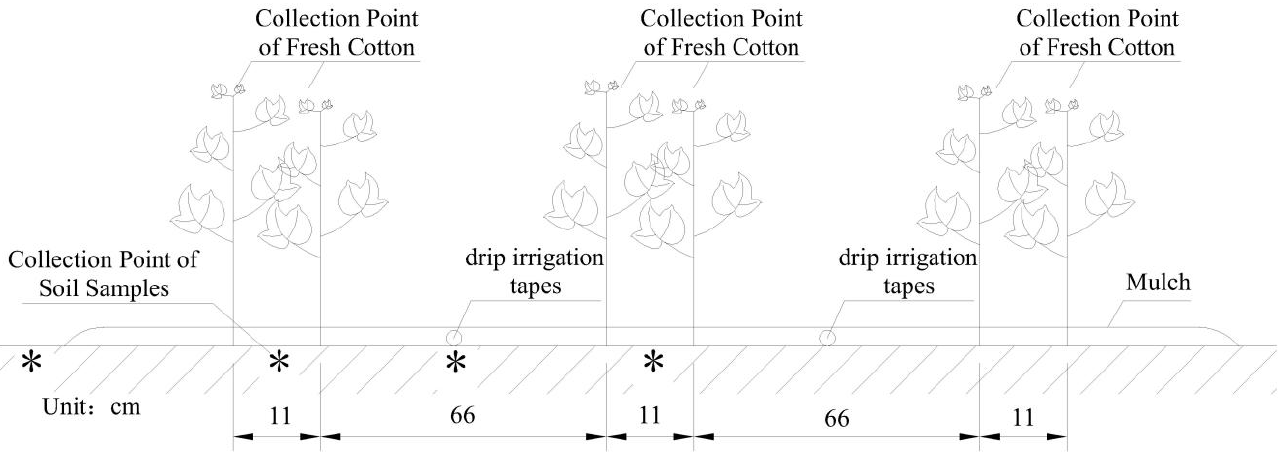
Figure 4. The planting layout and sampling sites. Table 2. Irrigation scheme.